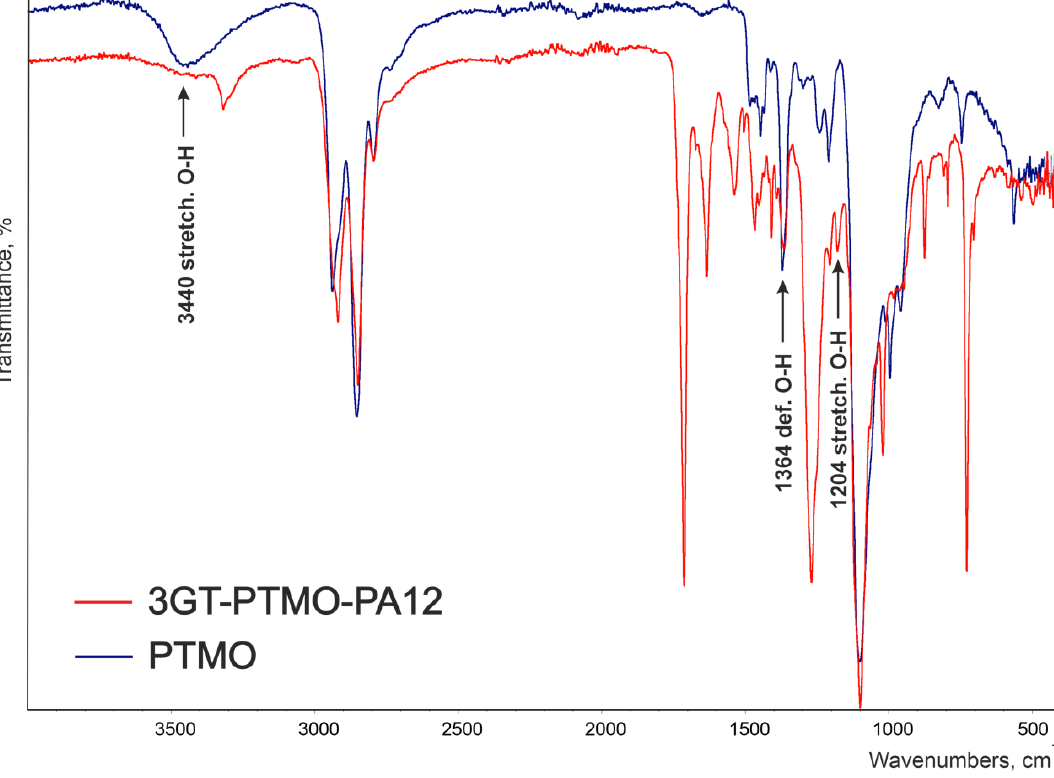
Figure 4. FT-IR spectrum of the reference terpolymer (3GT-PTMO-PA12) and PTMO homopoly- mer.